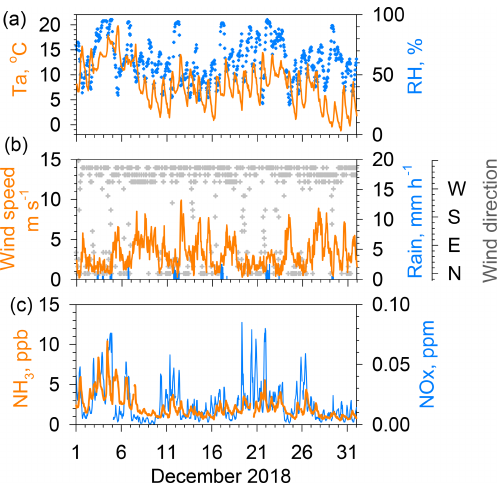
Figure 3. Same as Fig. 2 but for results obtained during Decem- ber 2018. The maximum of the vertical axis for NH 3 is reduced to 15ppb.